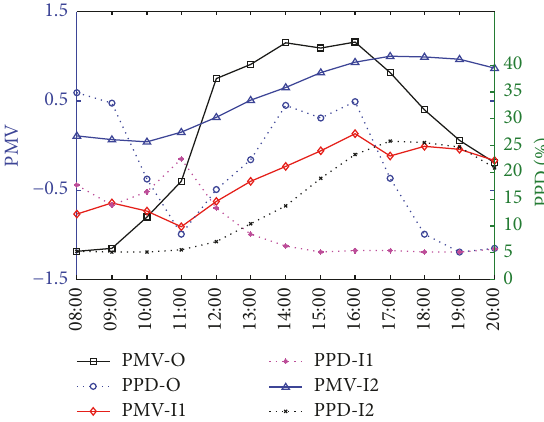
Figure 13: Comparison of PMV-PPD in the inner and outer